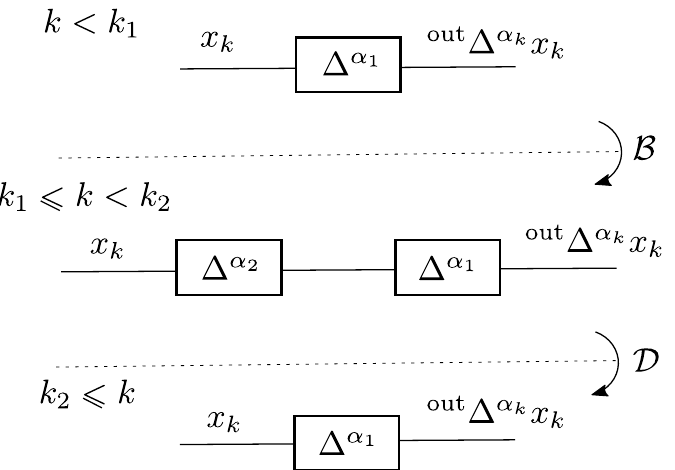
Figure 2. Conceptual analog model realization scheme of D -type